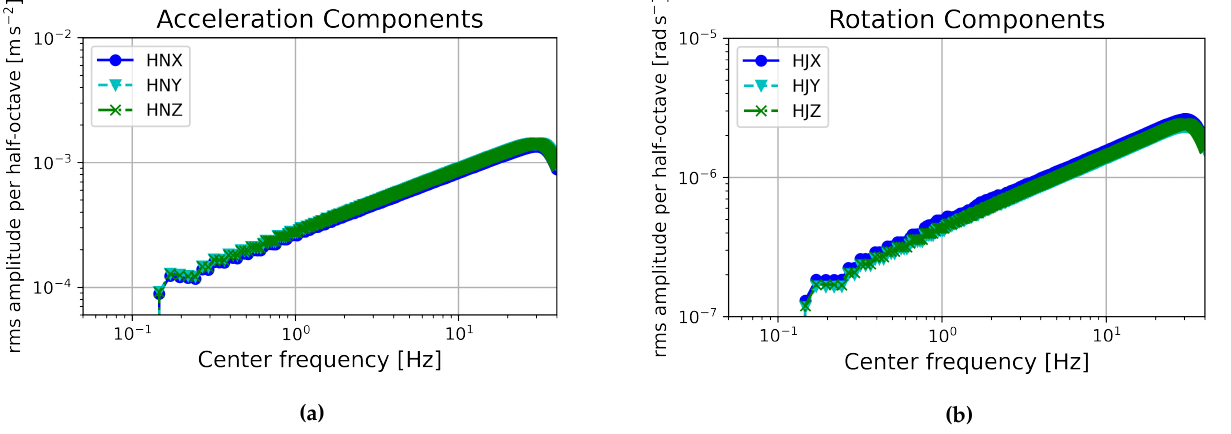
Figure 20. Operating range diagrams showing the root mean squared (rms) power spectral density of sensor self-noise integrated over each half-octave frequency for ( a ) the MEMS accelerometers and ( b ) the FOGs of sensor number 0083